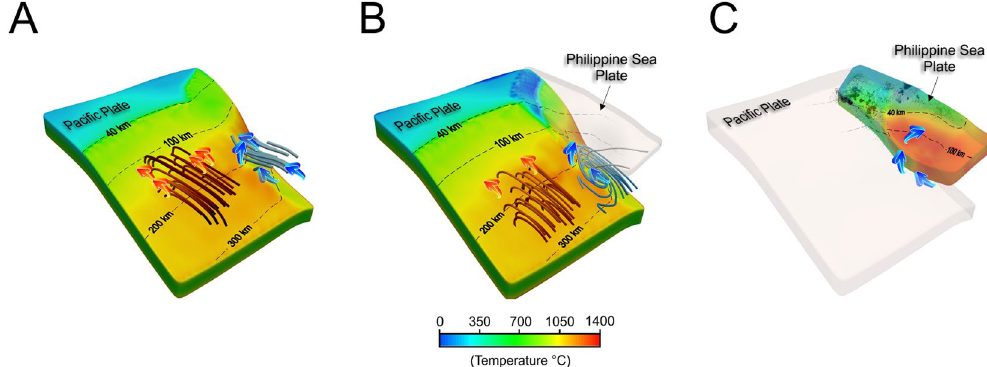
Figure 4. Slab surface temperature and mantle flow distribution. ( A ) Numerical experiment with a single plate (Pacific). Red and blight blue tubes depict the mantle wedge flow in two regions. Note the trench normal mantle flow in both areas (shown as red and blue arrows). ( B ) Numerical experiment with double subduction (Philippine Sea plate is shown as a semitransparent surface). Note the complex toroidal mantle flow underneath the Philippine Sea plate. ( C ) Temperature distribution inside the Philippine Sea plate. Black dots represent seismicity. Pacific plate is shown as a semitransparent surface. Blue arrows represent the mantle flow around the bottom of the Philippine Sea